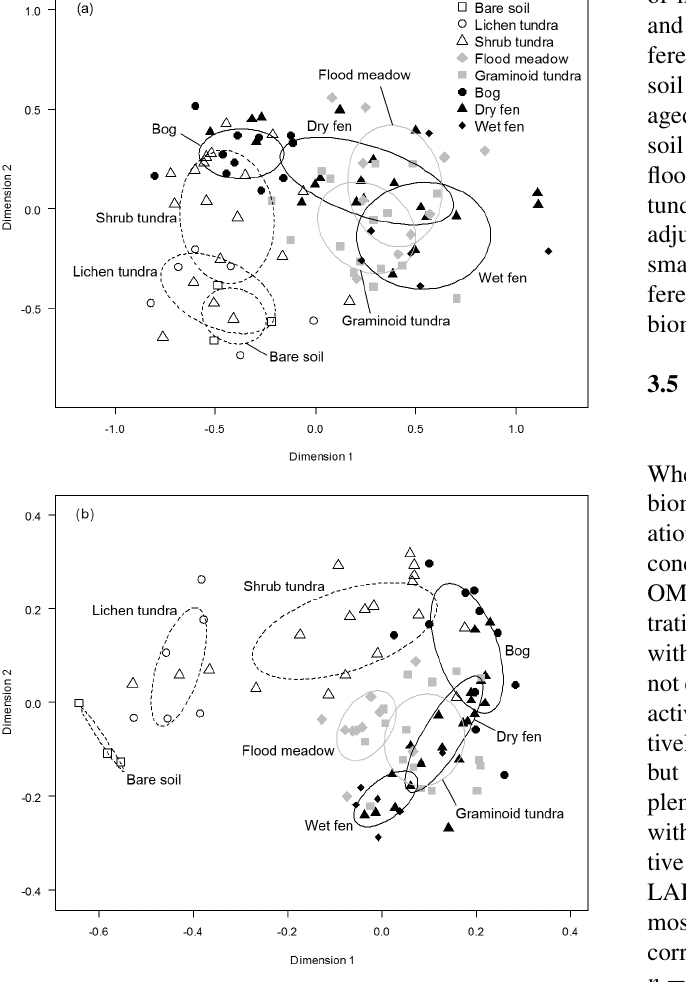
Figure 8. Non-metric multi-dimensional scaling (NMDS) graphs of (a) dicotyledonous plant species (presence/absence data) and (b) the combined data of plant functional group biomasses and soil vari- ables in ordination planes with the eight land cover types (LCTs), judged visually at the field site, as an overlay. Dispersion ellipses indicate 1 SD of the weighted averages of LCT